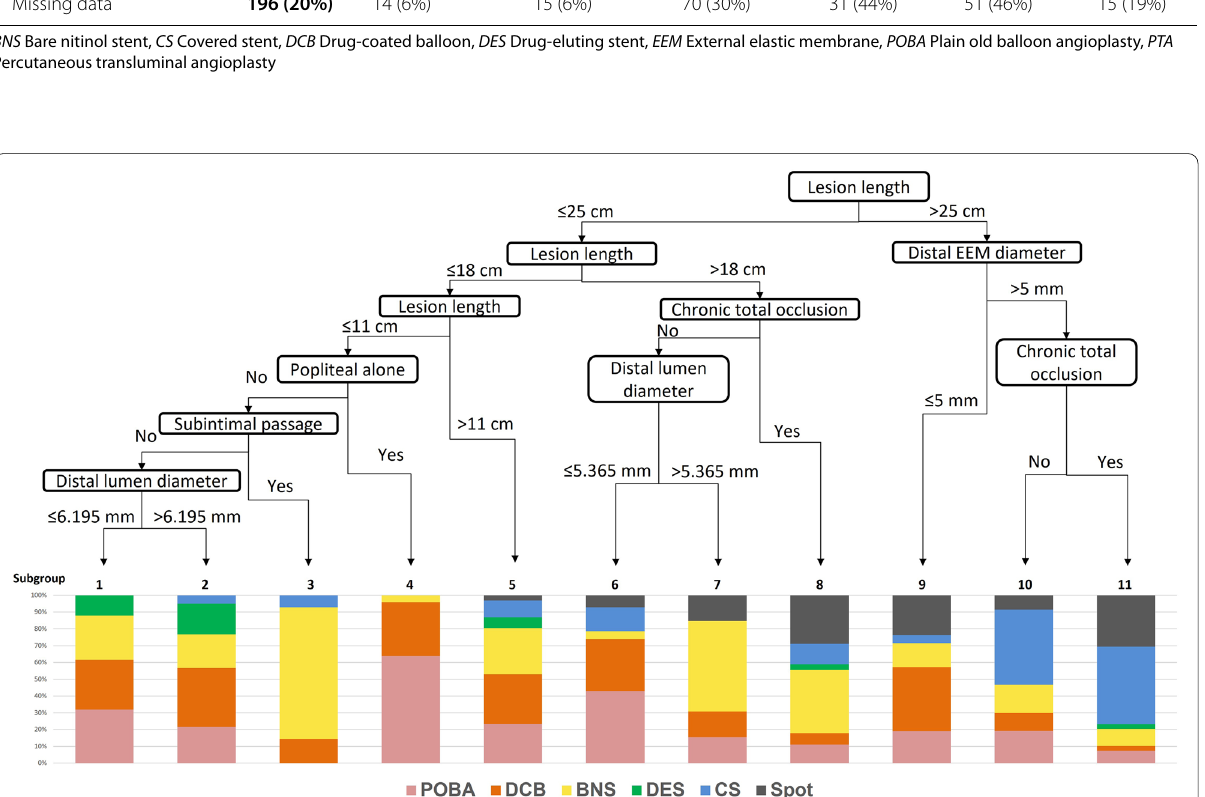
or DCB). The calcification and dissection pattern after post percutaneous transluminal angioplasty (PTA) was not identified as factors associated with the procedure